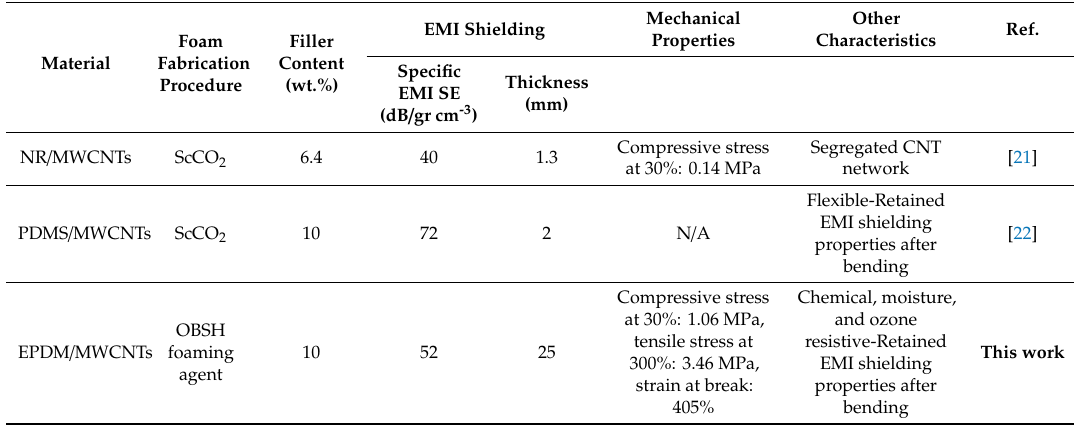
Table 3. EMI SE of rubber foam nanocomposites in the X-band frequency range.